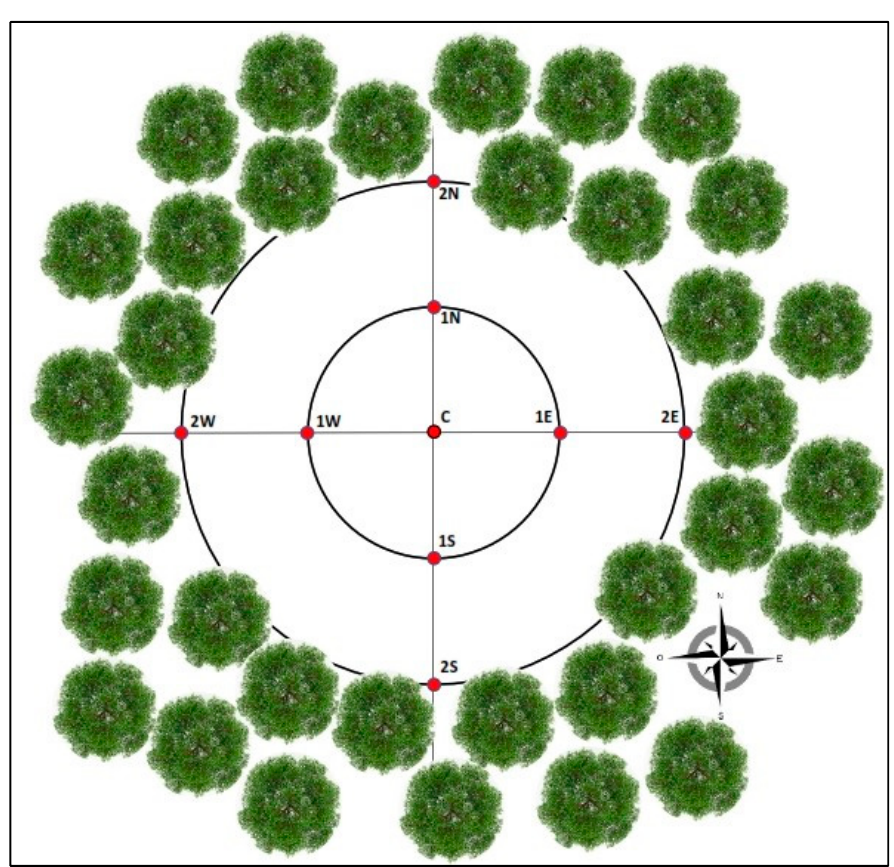
Figure 1. Plot design composed by nine circular subplots. The area of sub-plots C (center of each gap) and 1N, 1S, 1E, and 1W (sub-plots along the cardinal directions) was defined as the "center", while the area of sub-plots 2N, 2S, 2E, and 2W was defined as the "edge".